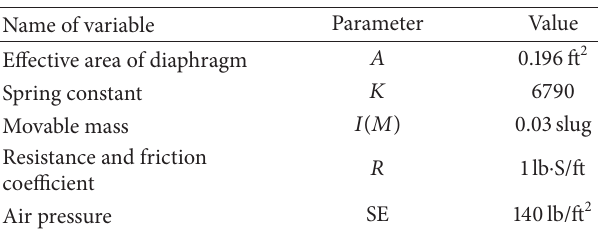
Table 1: Valve parameters [9].